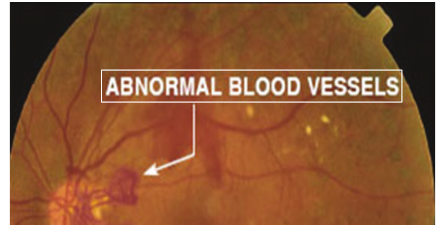
Figure 8: Abnormal blood